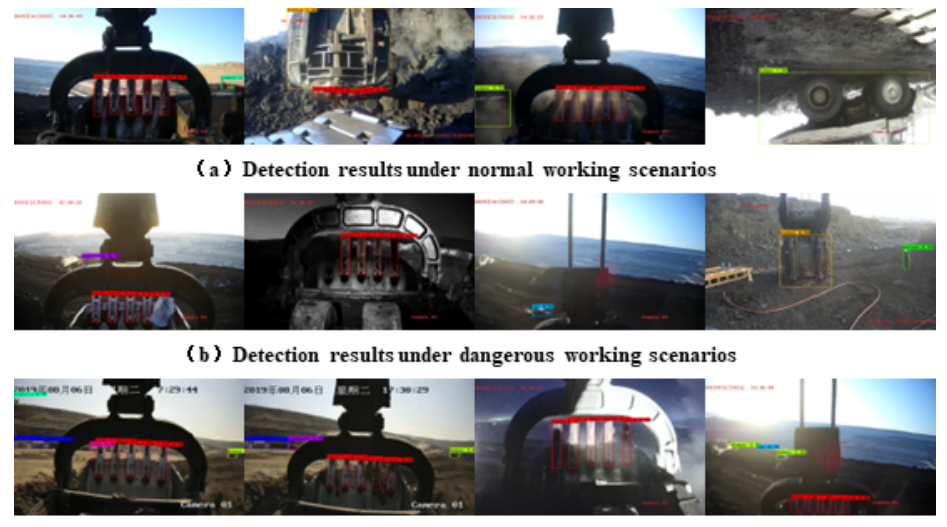
Figure 12. The detection results of YOLOX-CD-0.7 on the test sample set.